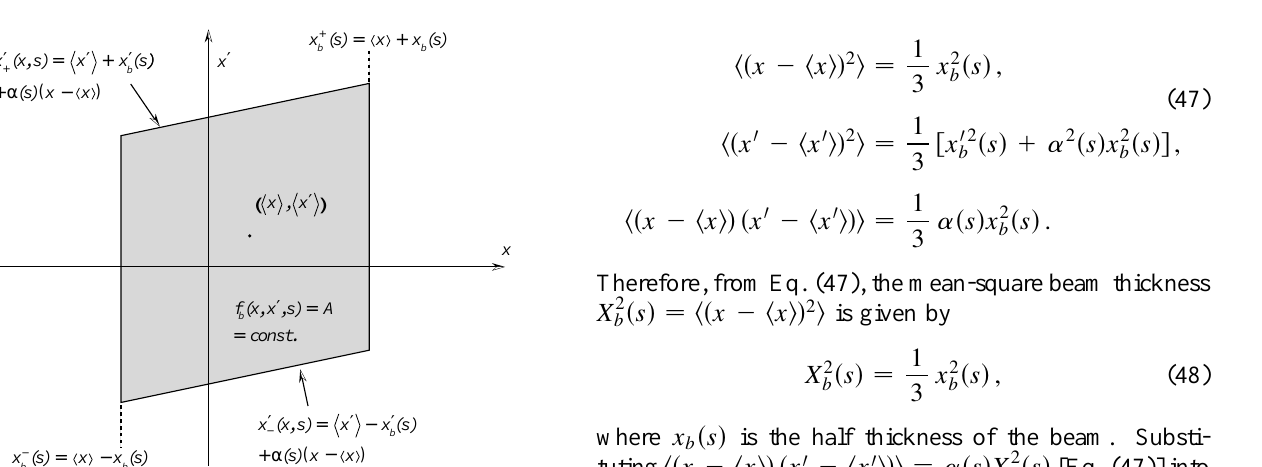
FIG. 2. Phase-space plot of distribution function f b (cid:1) x , s 0 , s (cid:2) (cid:1) A (cid:1) const in Eq. (40). Note that the boundary curves in the figure correspond to the parallelogram x 0 (cid:1) x 0 x 0 b (cid:1) s (cid:2) 1 a (cid:1) s (cid:2) (cid:1) x 2 (cid:7) x (cid:8)(cid:2) and x (cid:1) x 6 b (cid:1) s (cid:2) (cid:1) (cid:7) x (cid:8) 6 x b (cid:1) s (cid:2) , and that the parallelogram is centered at (cid:1) x , x 0 (cid:2) (cid:1) (cid:1)(cid:7) x (cid:8) , (cid:7) x 0 (cid:8)(cid:2) .